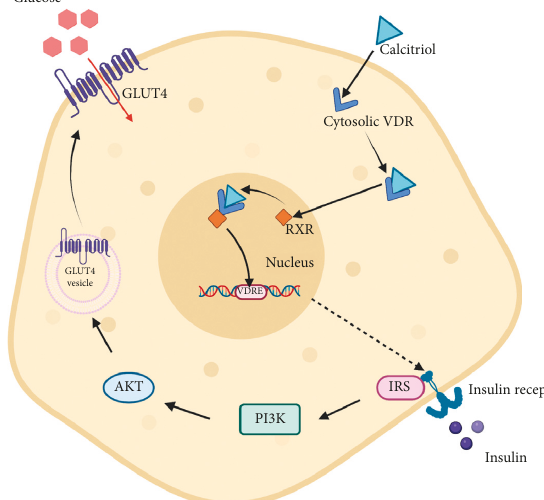
Figure 2: The mechanism underlying insulin-induced glucose uptake in a target cell. vitamin D in its active form, calcitriol binds to cytosolic VDR, which are then translocated into the nucleus and bind to RXR to form calcitriol-VDR-RXR complexes. The com- plexes then bind to VDRE within the Ir gene promoter regions to stimulate the transcription and upregulation of insulin receptor gene. The binding of insulin to IR stimulates a cascade of process involving multiple downstream mediators, including insulin re- ceptor substrate-1 (IRS-1) and PI3K. The resulting activation of protein kinase B (Akt) stimulates the translocation of glucose transporter type 4 (GLUT4) to the plasma membrane, which fa- cilitates the uptake of circulating glucose into the